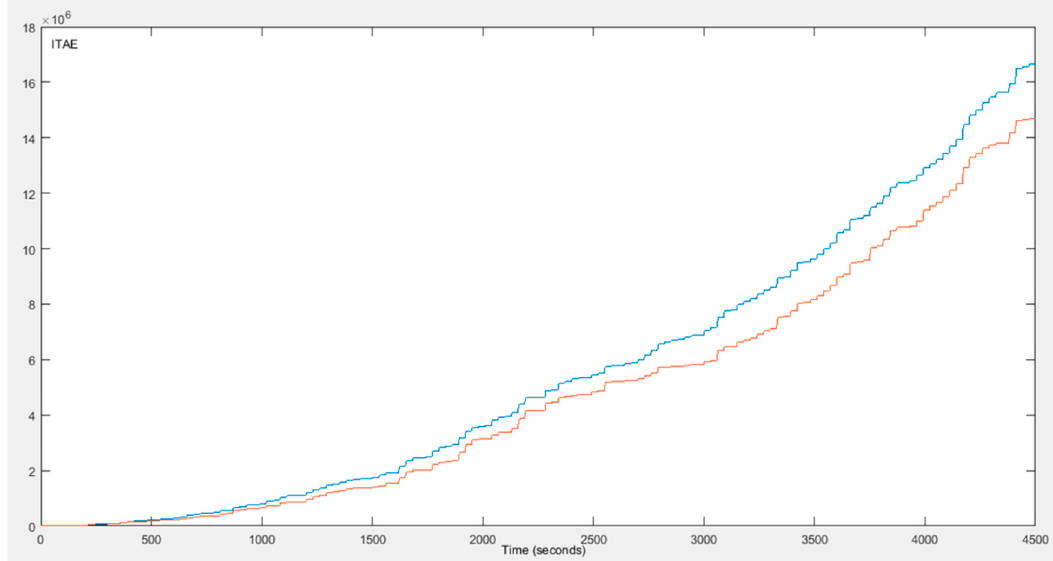
Figure 7. ITAE of conventional PID control strategy (blue line) and fuzzy Q-Learning PID control strategy (red line). Algorithms 2018 , 11 , 148